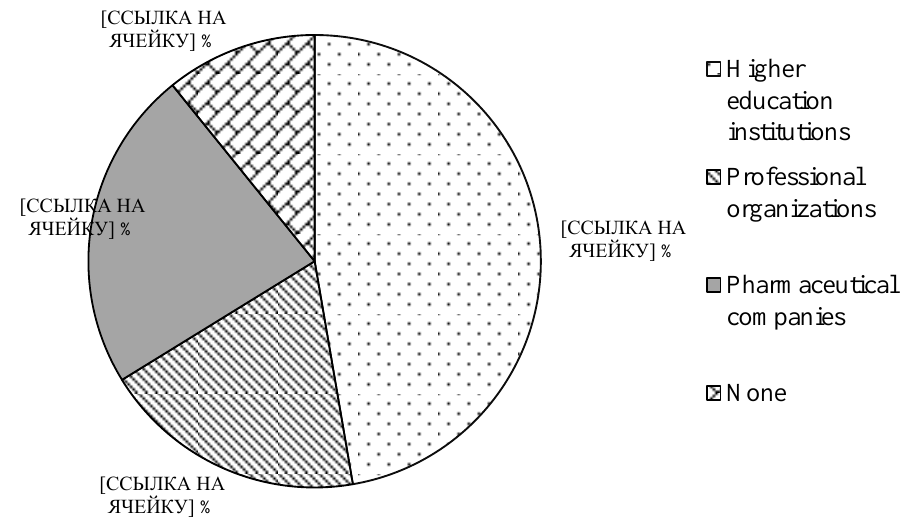
Fig. 6. Analysis of organizations to which pharmacy establishments refer to in-service training (according to the per- centage of pharmacy establishments using their